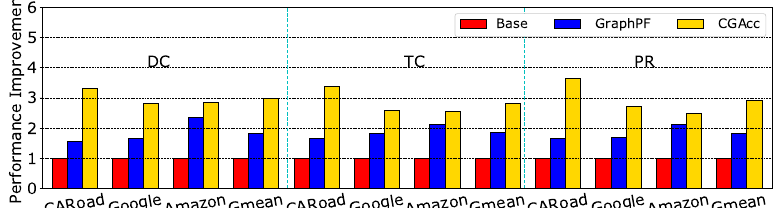
Figure 20. Comparison of performance between baseline, graph prefetcherand CGAcc on sequential-iteration applications.